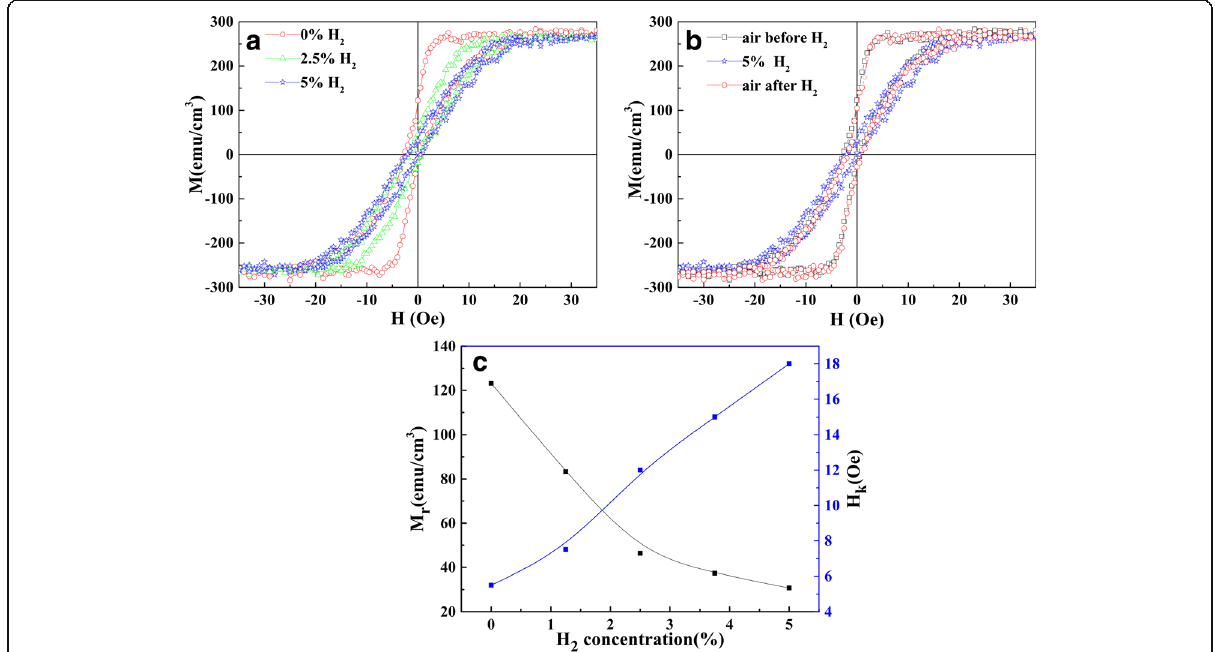
Fig. 4 The out-of-plane M-H loops for Ta/Pd/CFMS (2.3 nm)/MgO (1.3 nm)/Pd films annealed at 300 °C. a Under H 2 introduction. b Comparison after removing H 2 . c The dependence of M r and H k on H 2 concentration